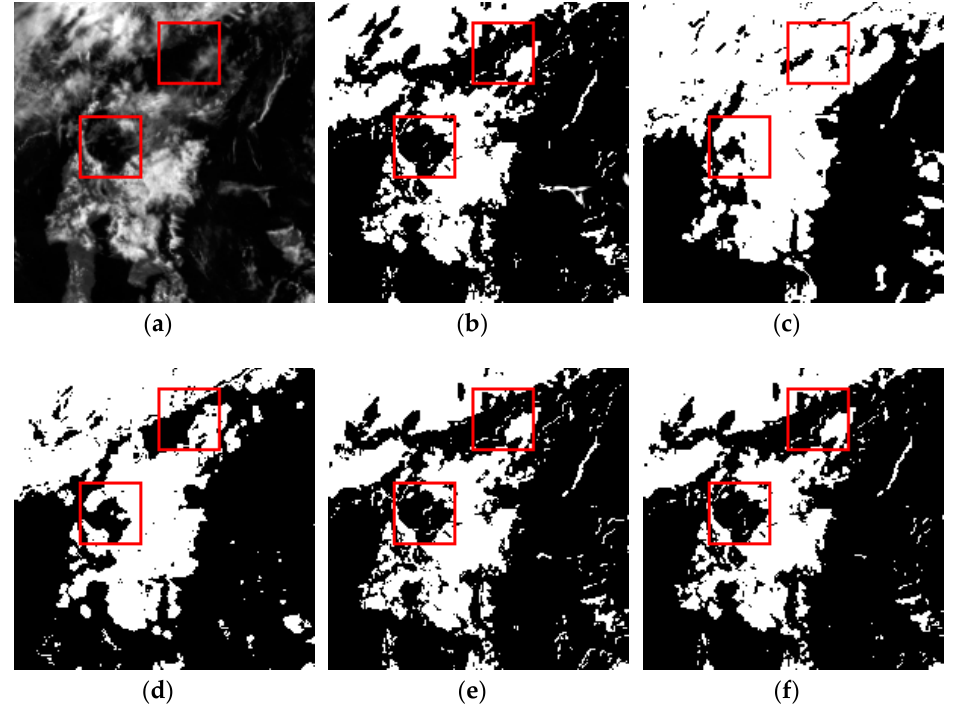
Figure 12. The enlarged subset of results. ( a ) Visible image; ( b ) Ground truth; ( c ) NSMC result; ( d ) NSMC-RF result; ( e ) Ensemble threshold-RF result; ( f ) Proposed RF result.